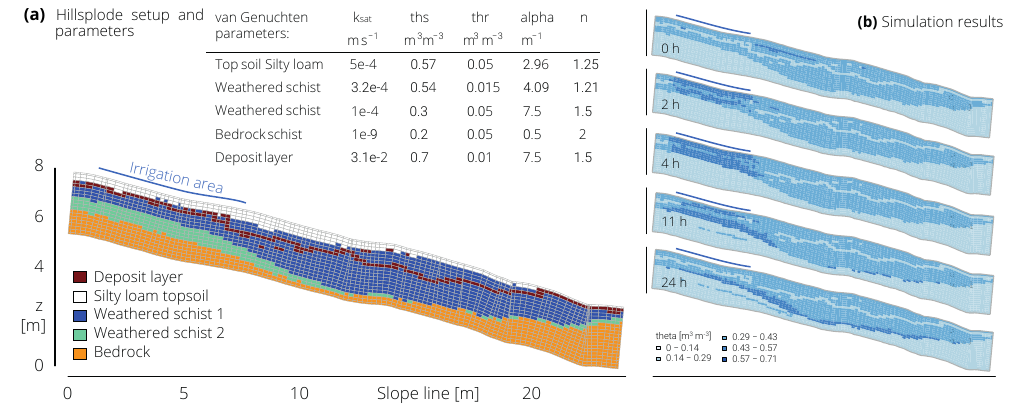
Figure C1. CATFLOW model reference of the hillslope experiment. (a) Table of used soil definitions and hypothetical hillslope setup. (b) Simulated soil moisture with 30mmh − 1 irrigation for